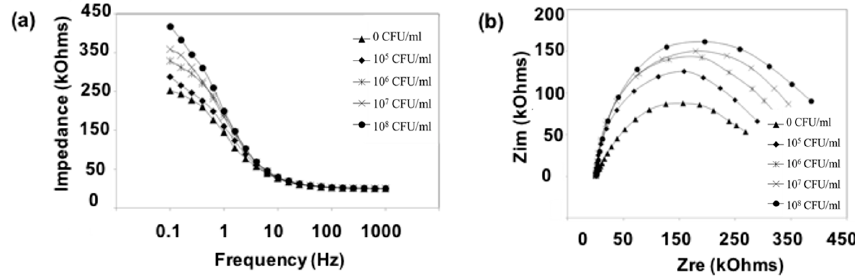
Figure 4. Bode plot ( a ) and Nyquist diagram ( b ) of the Faradaic impedance measurements of a mannose modified electrode in the presence of different concentrations of K. pneumoniae KCTC 2242 (from 10 5 to 10 8 CFU/mL). Impedance spectra were measured within the frequency ranging from 0.1 to 1 kHz at the potential of the [Fe(CN) 6 ] 3 − /4 − redox probe. The amplitude of the alternating voltage was 5 mV.